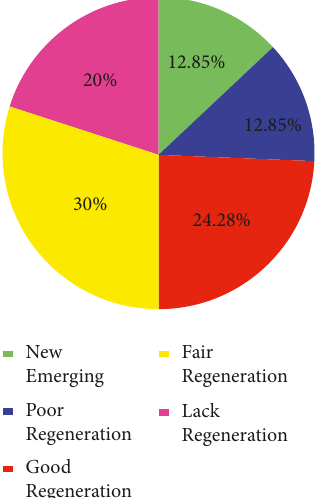
Figure 6: Regeneration status of tree and shrub species in the national